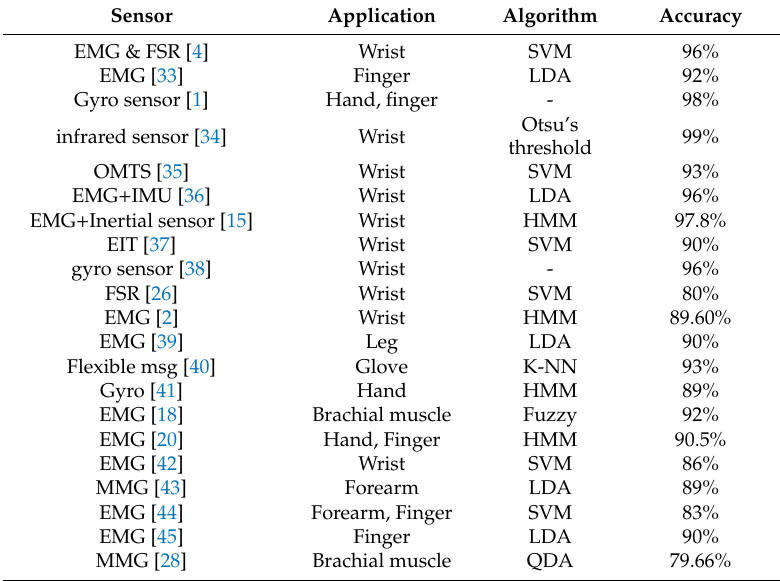
Table 4. Results from previous studies on gesture recognition